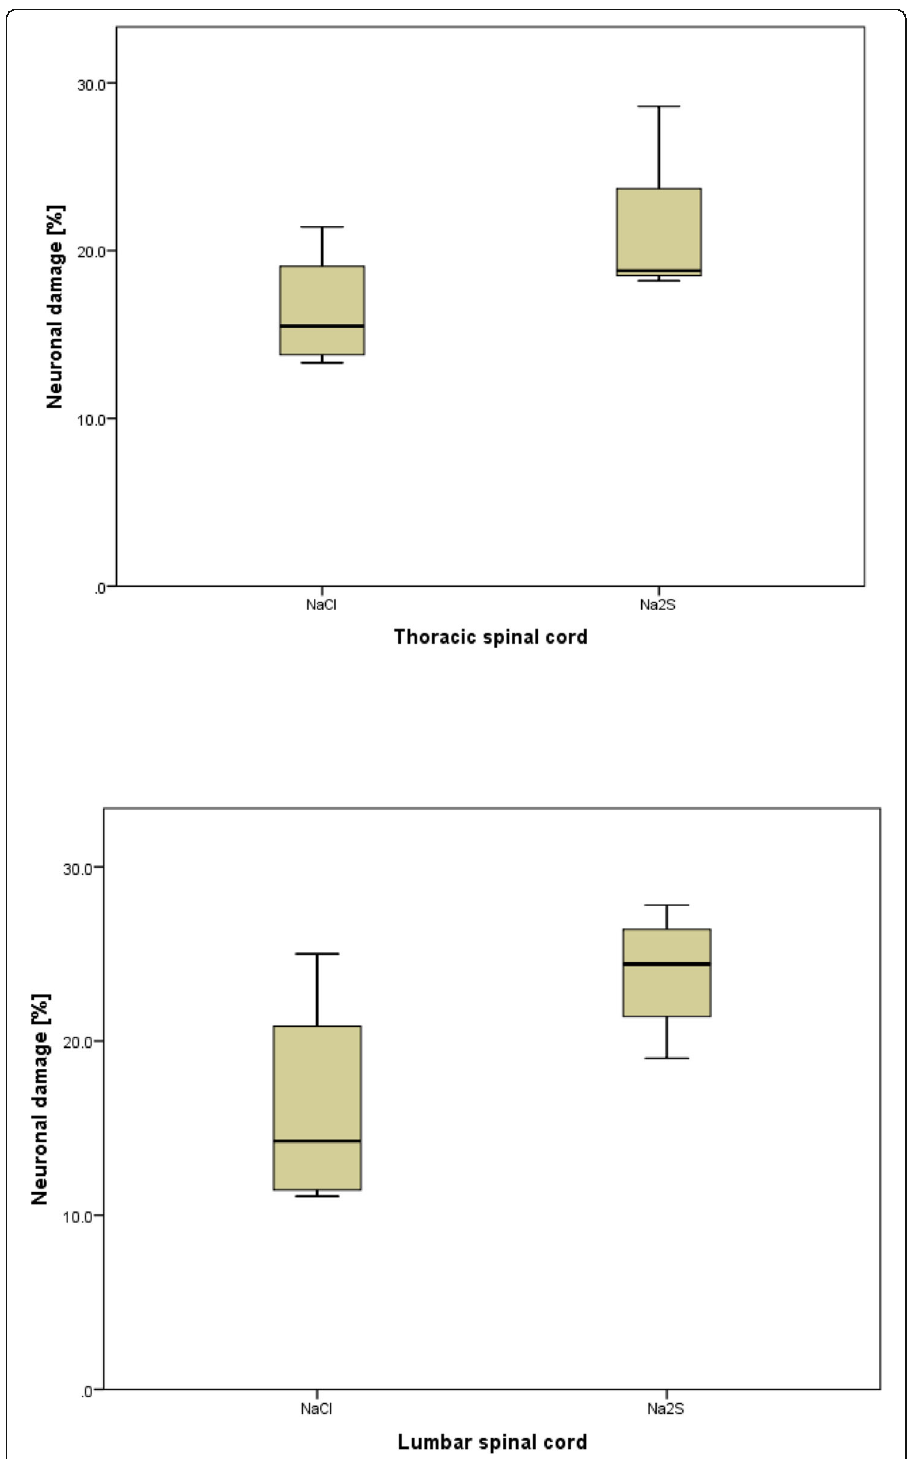
Fig. 1 Percentage of damaged motoneurons in the spinal cord. Percentage of damaged neurons within the spinal cord at thoracic (upper graphic) and lumbar levels (bottom). Data shown as median (interquartile range). Sodium chloride (NaCl) n = 4, sodium sulfide (Na 2 S) n =